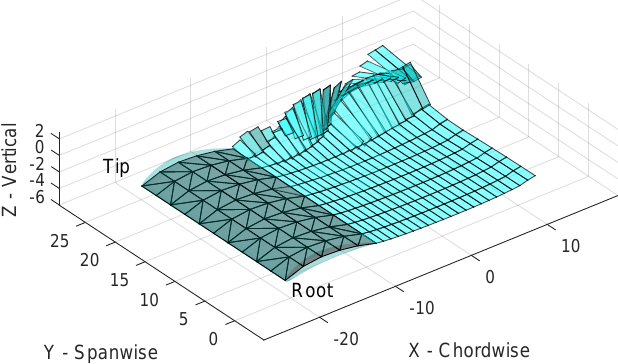
Figure 3. Higher-order elements placed along the camber plane of a rectangular wing and the corresponding relaxed wake